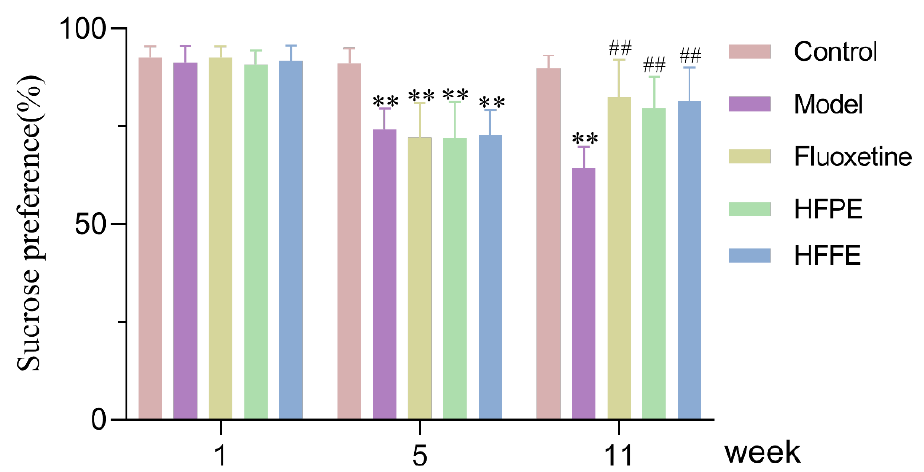
Figure 5. Effects of HFPE and HFFE on the sucrose preference before and after CUMS procedure. The values were represented as mean ± SD ( n = 10). ** p < 0.01 compared with the control group, ## p < 0.01 compared with the model group.